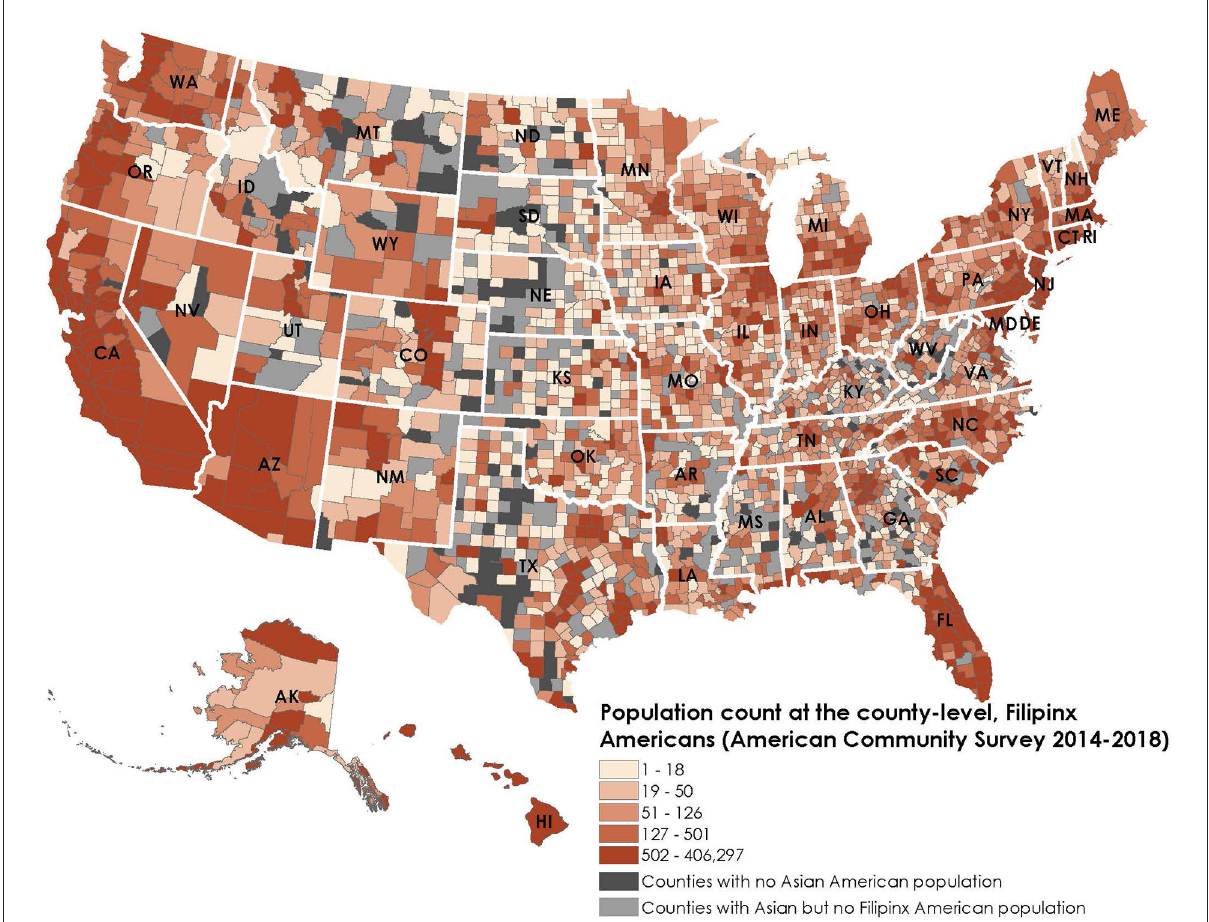
FIGURE1 Population count, Filipinx Americans, county-level,